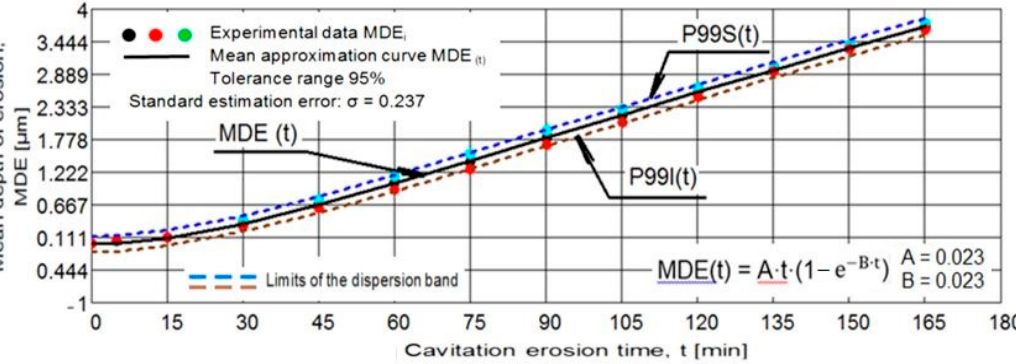
Figure 6. The dispersion range of the experimental values for the nitrided samples. Statistical reference parameters of the dispersion band.